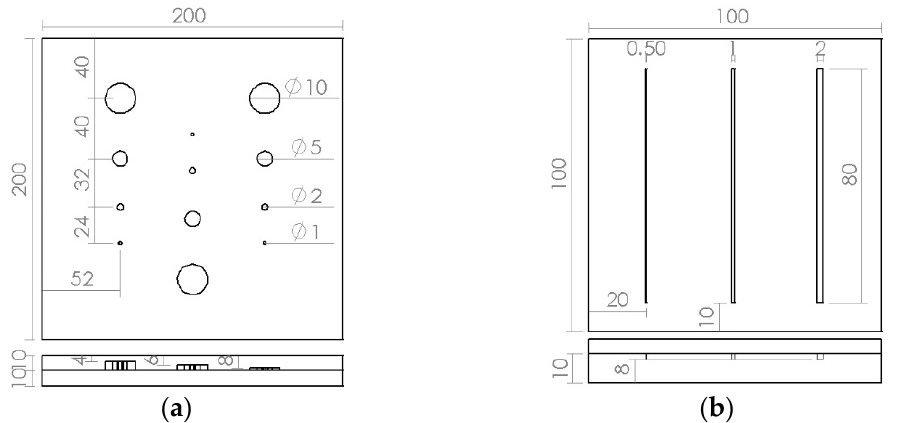
Figure 4. Design drawings of test specimens with artificial defects (unit: mm). ( a ) Voids in silicone rubber. ( b ) Cracks in fiber-reinforced plastic.